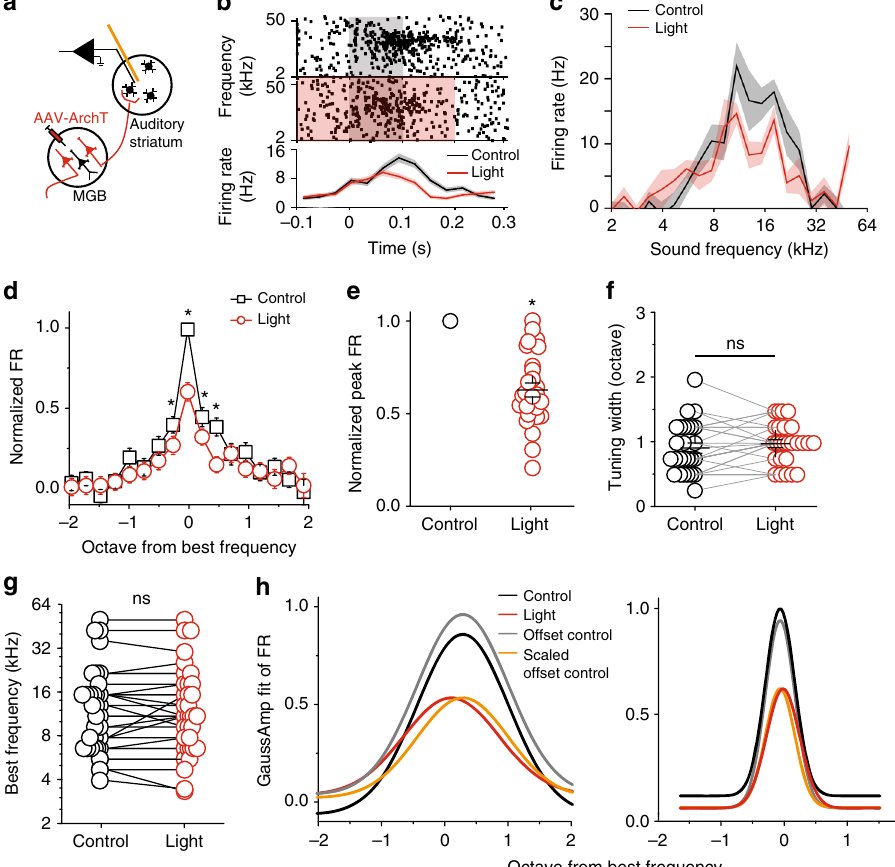
Fig. 3 Silencing the MGB projection to the auditory striatum reduced striatal MSN tonal responses across frequencies. a Illustration of recording setup for silencing MGB projection. b One example of recorded MSN single unit. Upper panels, raster plots of a MSN fi rings during tone presentation (gray shaded area) and tone + light presentation (red + gray shaded area). Tone: 0 – 0.1 s time window; Light: − 0.1 to 0.2 s time window. Lower panel, peristimulus time histogram (PSTH) of the fi ring rates in response to tone alone (black) and tone + light (red). c Tuning plots of the example shown in ( b ). d Average tuning plots at the tone alone (black) and tone + light (red) conditions. Frequencies are aligned to the best frequency of each single unit and scaled in octave away from the best frequency. The best frequencies are determined separately from control and light-on trials for each single unit. Firing rates at different frequencies of each single unit are normalized to the fi ring rate at the best frequency from control trials. e Normalized individual and averaged fi ring rates at best frequencies at the tone alone (black) and tone + light (red) conditions. f The tuning widths (the frequency range at half peak fi ring rate) at the tone alone (black) and tone + light (red) conditions. g The best frequencies at the tone alone (black) and tone + light (red) conditions. h The fi tted tuning curves with a Gaussian function ( R ( f ) = A × exp( − 0.5 × ( θ – f 0 ) 2 / σ 2 ) + B, where B represents the baseline response, A represents the amplitude of the strongest evoked response, f 0 represents the preferred frequency, and σ is the tuning width). Left panel: the fi tted curves from the same example neurons shown in ( b and c ). Right panel: the fi tted curves from the population data shown in ( d ). Black, control condition; red, light-on condition; gray, offset the black curve to the baseline of the red curve; orange, scaled down the gray curve. For d – h , n = 26 neurons from fi ve mice, data are presented as mean values, error bars are s.e.m., * p < 0.01, t test in ( d ) and paired t test in ( e – g ) NATURE COMMUNICATIONS| (2019) 10:418